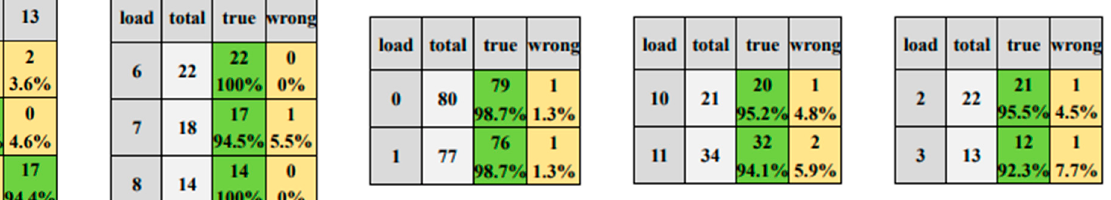
Figure 10. Identi fi cation results of multi-state load and similar load. ( Green means true, yellow Figure 10. Identification results of multi-state load and similar load. (Green means true, yellow means false ) means false).